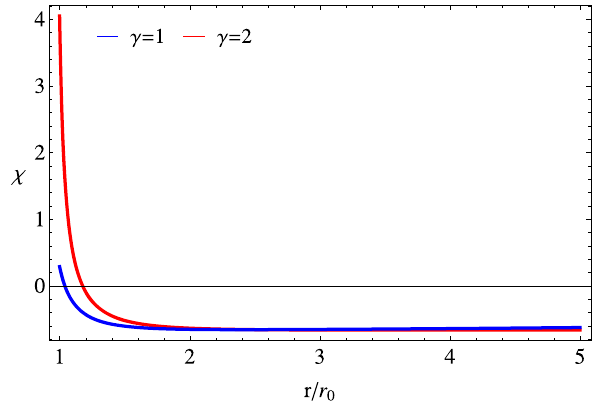
Fig. 10 The exoticity parameter χ versus the dimensionless radial coordinate r / r 0 . These curves were obtained by considering the val- ues mentioned in Table 5, for the model #2